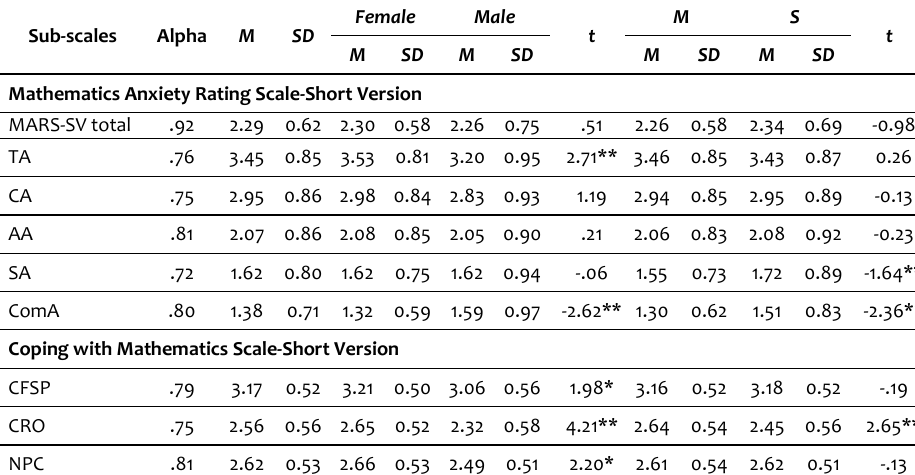
Table 1. MARS-SV and CMS-SV Sub-scale means, standard deviations, internal consistency coefficients, and t-test results according to gender and field Sub-scales